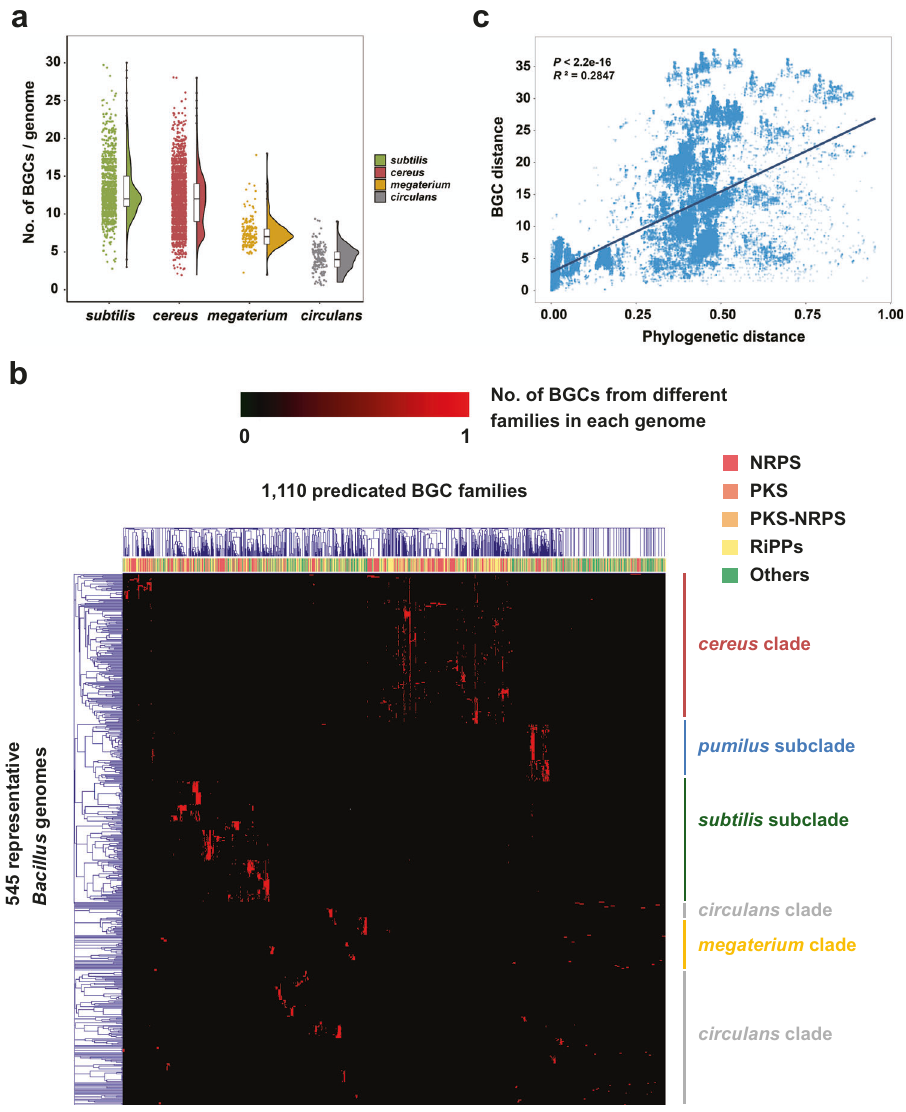
Fig. 2 Biosynthetic gene cluster (BGC) distribution is correlated with phylogeny in the genus Bacillus . a The numbers of BGCs in the 4268 Bacillus genomes from different clades as de fi ned by antiSMASH 15 . In the violin plot, the centre line represents the median, violin edges show the 25th and 75th percentiles, and whiskers extend to 1.5× the interquartile range. b Hierarchal clustering among the 545 representative Bacillus genomes based on the abundance of the different biosynthesis gene cluster families (GCFs). Each column represents a GCF, which was classi fi ed through BiG-SCAPE by calculating the Jaccard index (JI), adjacency index (AI), and domain sequence similarity (DSS) of each BGC 28 ; the color bar on the top of the heatmap represents the BGC class of each GCF, where PKS includes classes of PKSother and PKSI, PKS-NRPS means PKS-NRPS Hybrids, Others includes classes of saccharides, terpene, and others. Each row represents a Bacillus genome, and the abundance of each GCF in different genomes is shown in the heatmap. The left tree was constructed based on the distribution pattern of GCFs, which showes a similar pattern to the phylogram in Fig. 1. c The correlation between the BGC and phylogenetic distance of the 545 representative Bacillus genomes ( P < 2.2 × 10 − 16 , R 2 = 0.2847). Linear model (LM) was used for the correlation analysis and adjustments were made for R 2 calculation; one-sided F test was applied for multiple comparisons (F-statistic: 5.669 × 10 4 on 1 and 142,436 DF). Source data are provided as a Source Data fi